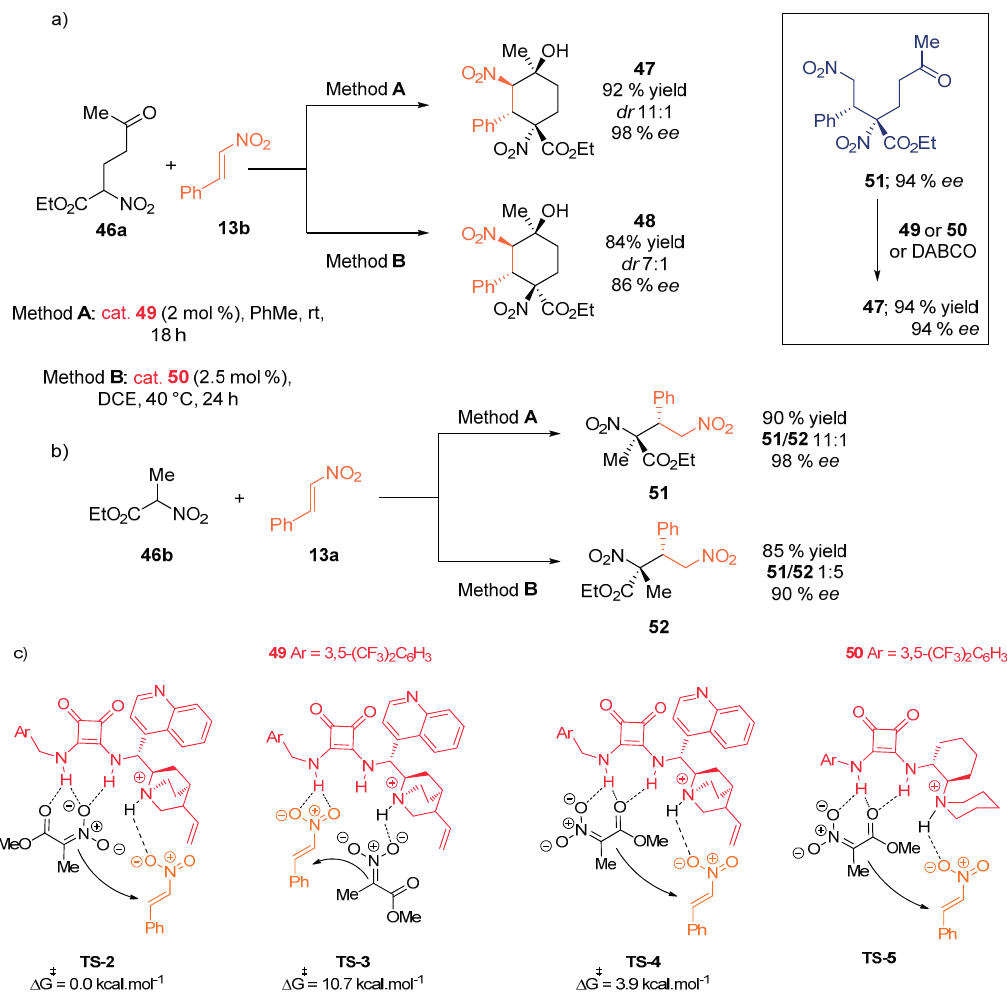
Figure 12. Diastereodivergent Michael addition for the synthesis of substituted cyclohexanes ( a ); synthesis of simplified products ( b ); transition states with catalysts 49 and 50 ( c